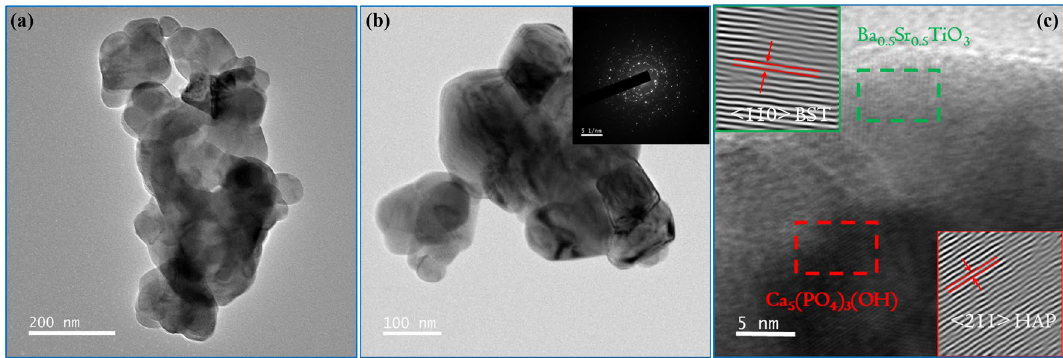
Figure 11. ( a ) The FETEM image of a selected region of 20H–80B showing the morphology of monoliths ( b ) the images of a different region at higher magnification as well as the SAED pattern of the region (inset) and ( c ) the HRTEM images of a different region along with their IFFT images in the inset. The lattice planes from the monoliths can be identified from the HRTEM images, as shown in ( c